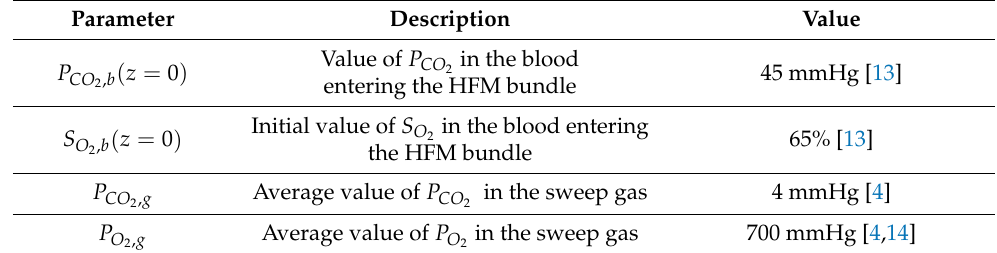
Table 1. Physical Constants for O 2 and CO 2